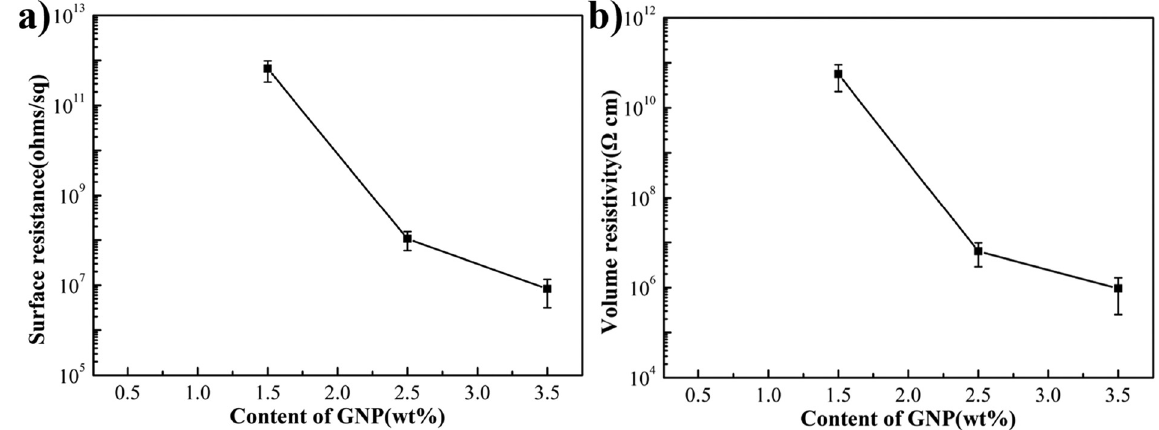
Figure A2: Surface resistivity ( a ) and volume resistivity ( b ) of composites prepared by two - screw compounding.